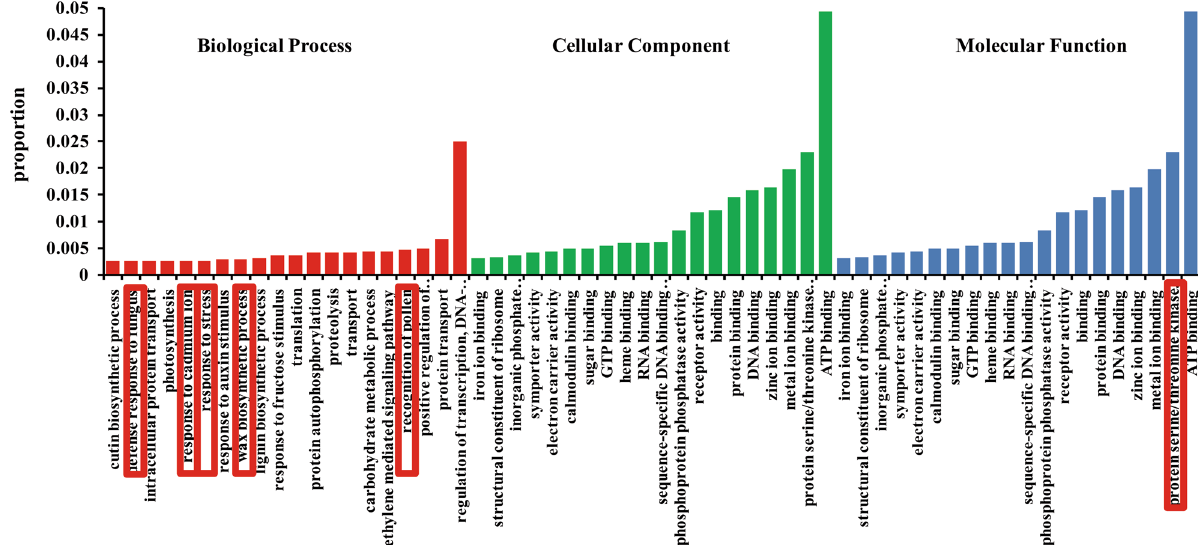
Figure 7. Functional categories of the genes with a high recombination